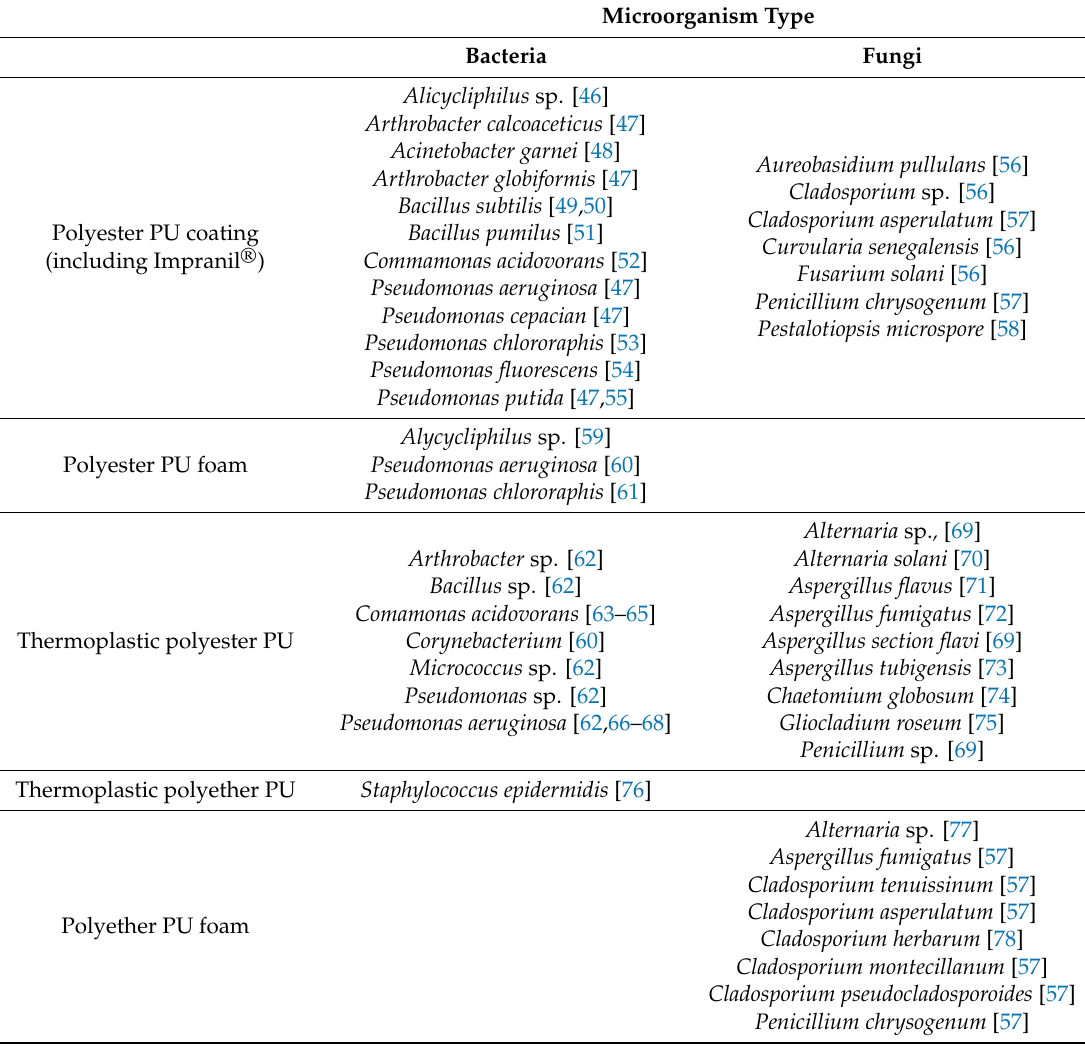
Table 3. Bacterial and fungal strains degrading di ff erent kinds of